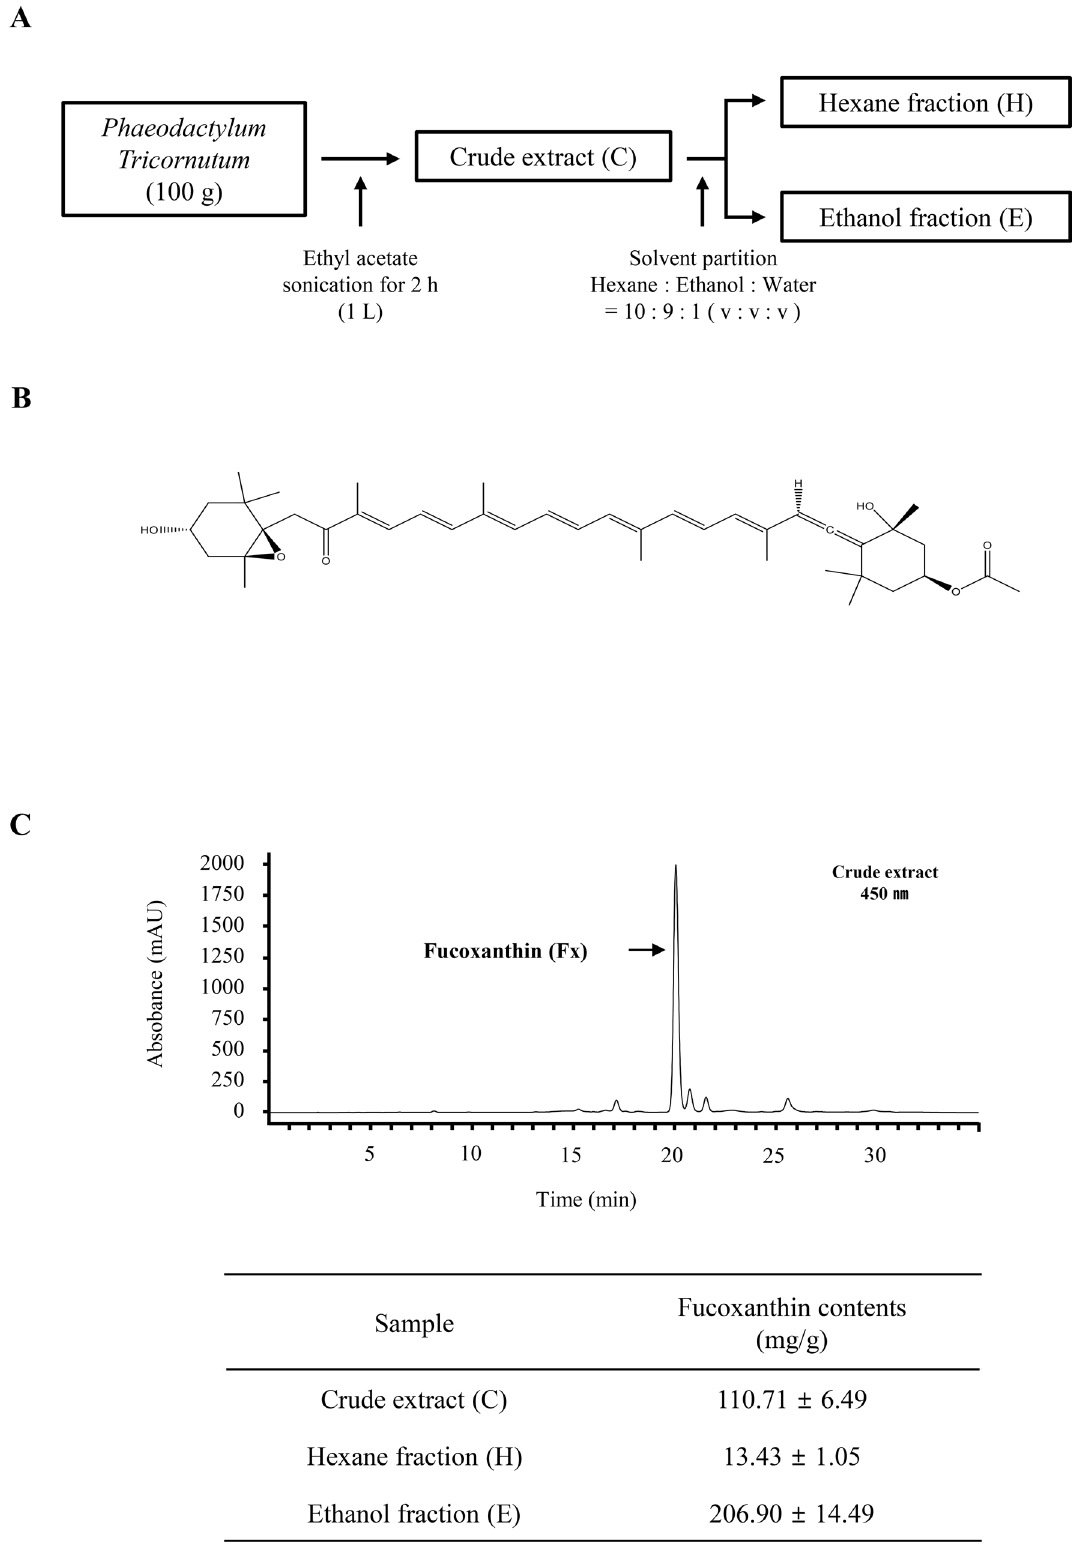
Figure 1. Extraction process and chemical structure of fucoxanthin from microalgae Phaeodactylum tricornutum ( A , B ). Quantification of fucoxanthin contents in three fractions of Phaeodactylum tricornutum extracts ( C ). C, Crude; H, Hexane; E,